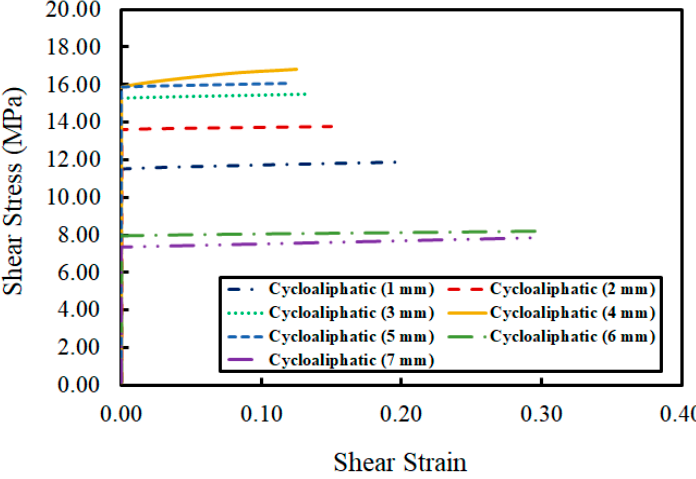
Figure 7. Relationship between shear strain and shear stress for Adhesive 2.